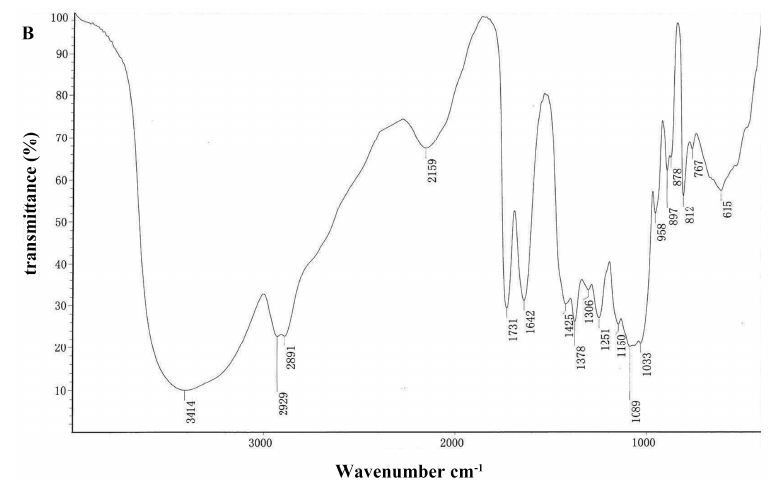
Figure 2. The FTIR spectra of DOPA-1 ( A ) and DOPA-2 ( B ).